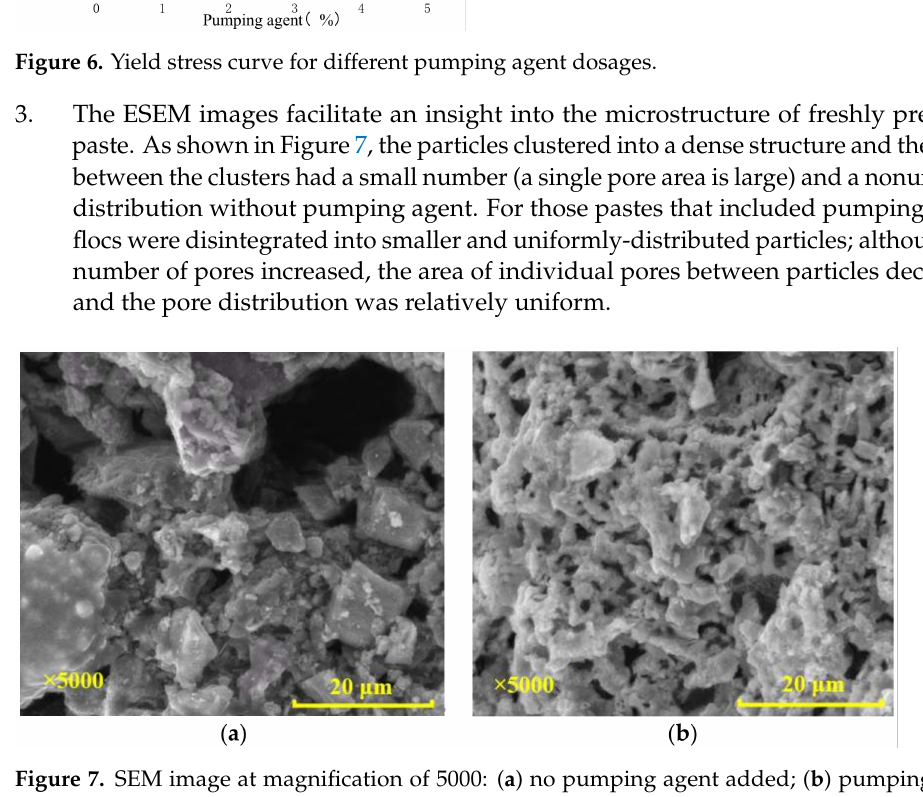
Figure 7. SEM image at magnification of 5000: ( a ) no pumping agent added; ( b ) pumping agent